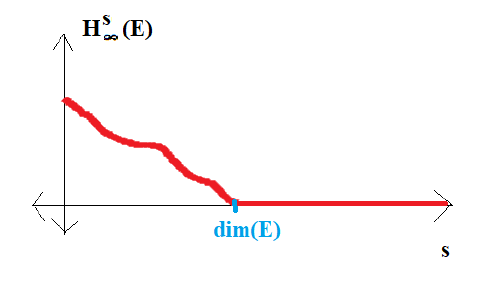
Figure 5. Hausdorff